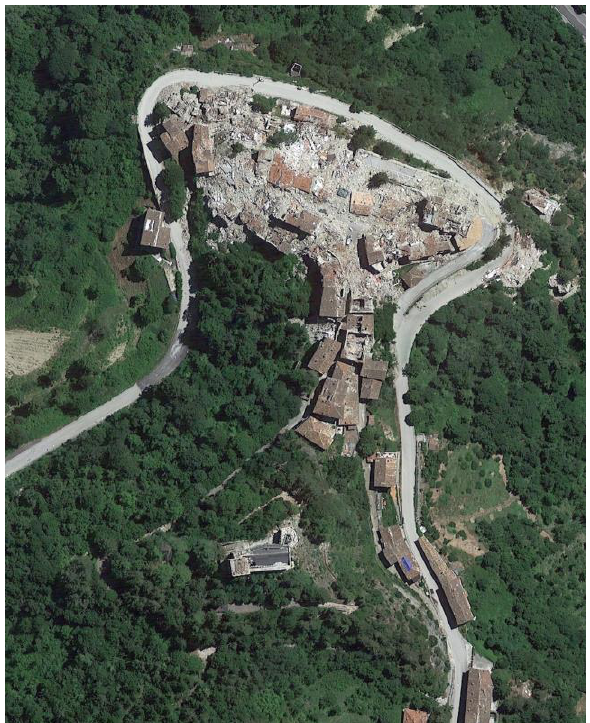
Figure 1. Arquata del Tronto (Ascoli Piceno), aerial